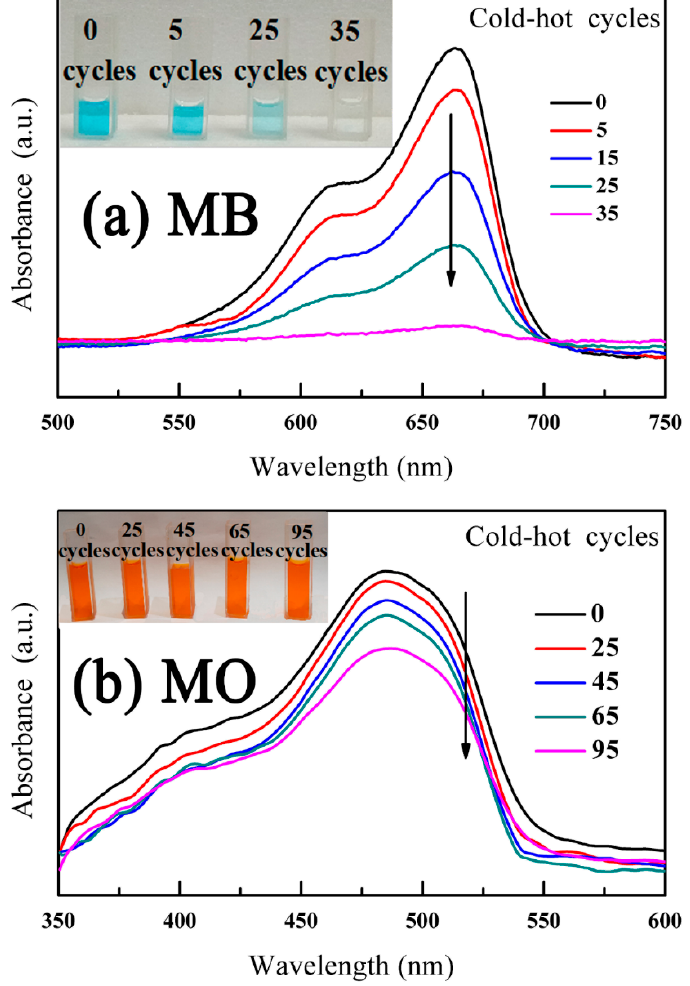
Figure 8. The characterization of pyro-catalysis performance of BNT: ( a ) MB and ( b ) MO dye solutions. The inset shows pictures of MB or MO dye decomposition.